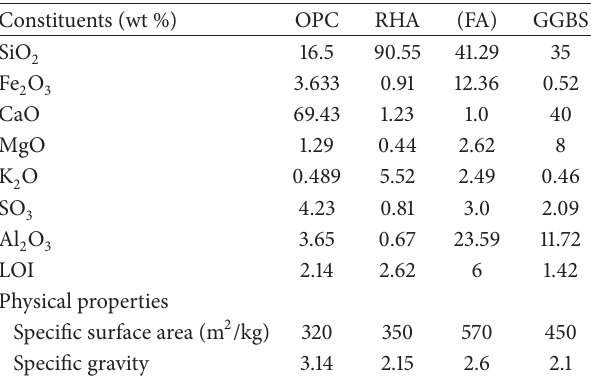
Table 2: Chemical composition of binder